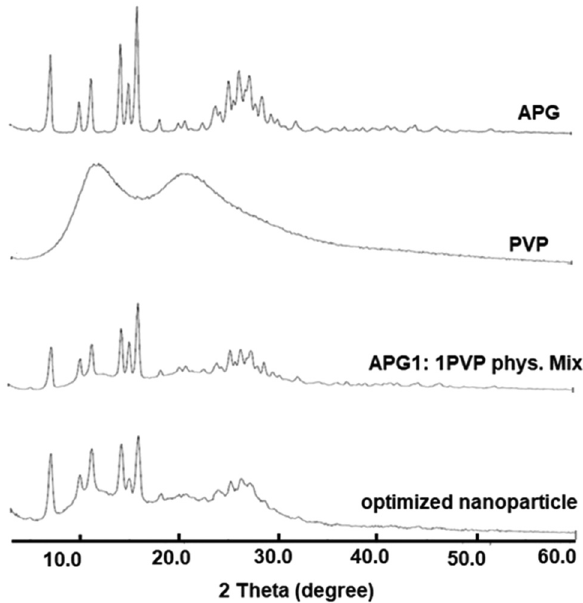
Figure 7: X - ray powder di ff raction spectra of APG, PVP, APG 1:1 PVP physical mixture and the optimized APG nanoparticle formula.